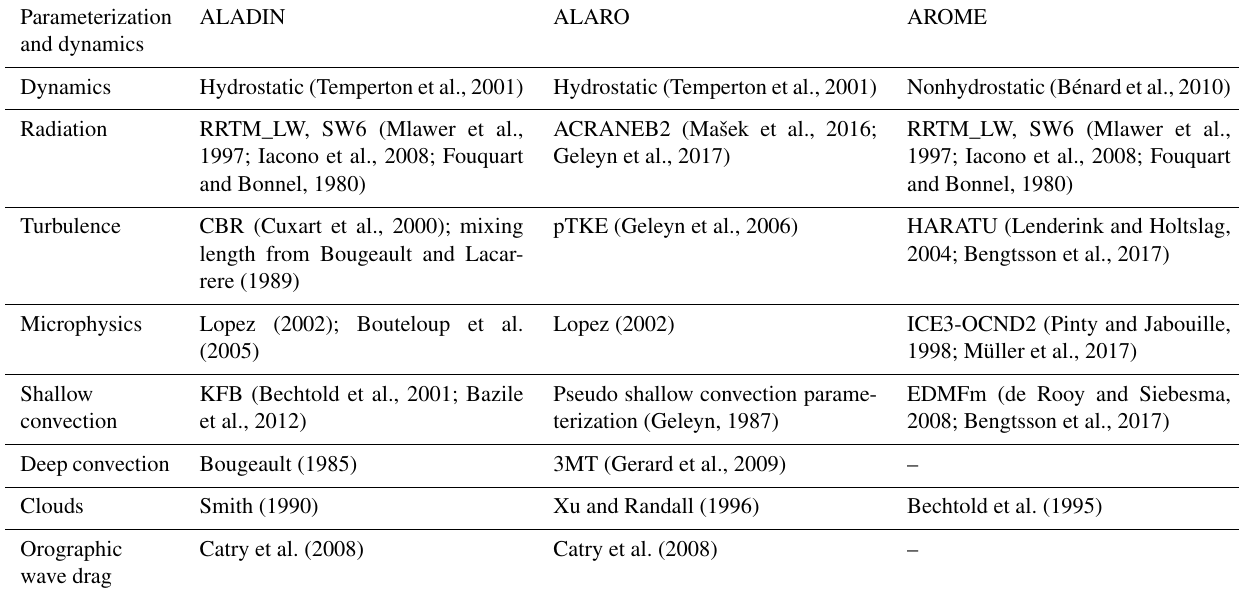
Table 3. Parameterizations and dynamics of the three model configurations as used in HCLIM38.